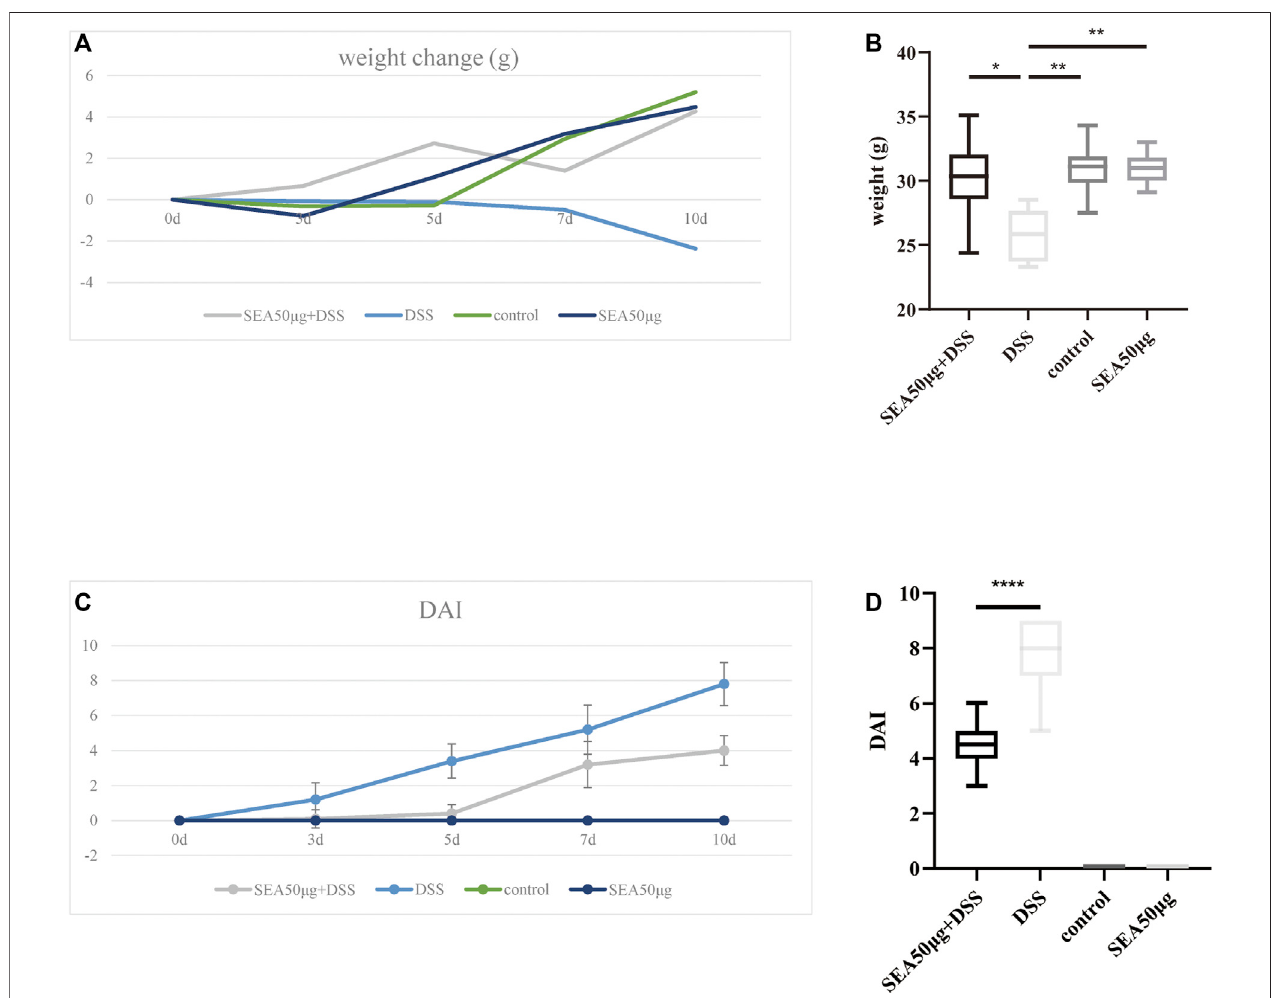
FIGURE 1 | SEA downregulated the DAI score in mice with DSS-induced IBD. (A) Changes in average body weight in the control group, SEA 50 μ g group, DSS group, and DSS+SEA 50 μ ggroup after 0,3,5,7,and 10 days. (B) Bodyweight inthecontrolgroup, SEA50 μ ggroup, DSSgroup, andDSS +SEA50 μ ggroupafter 10 days. (C) DAI changes in mice in the control group, SEA 50 μ g group, DSS group, and DSS + SEA 50 μ g group after 0, 3, 5, 7, and 10 days. (D) Comparison of the 10-days DAI score between the SEA 50 μ g + DSS and DSS